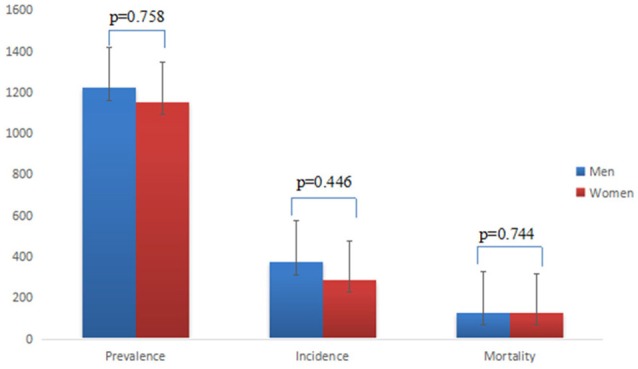
Sex-specific prevalence, incidence, and mortality.